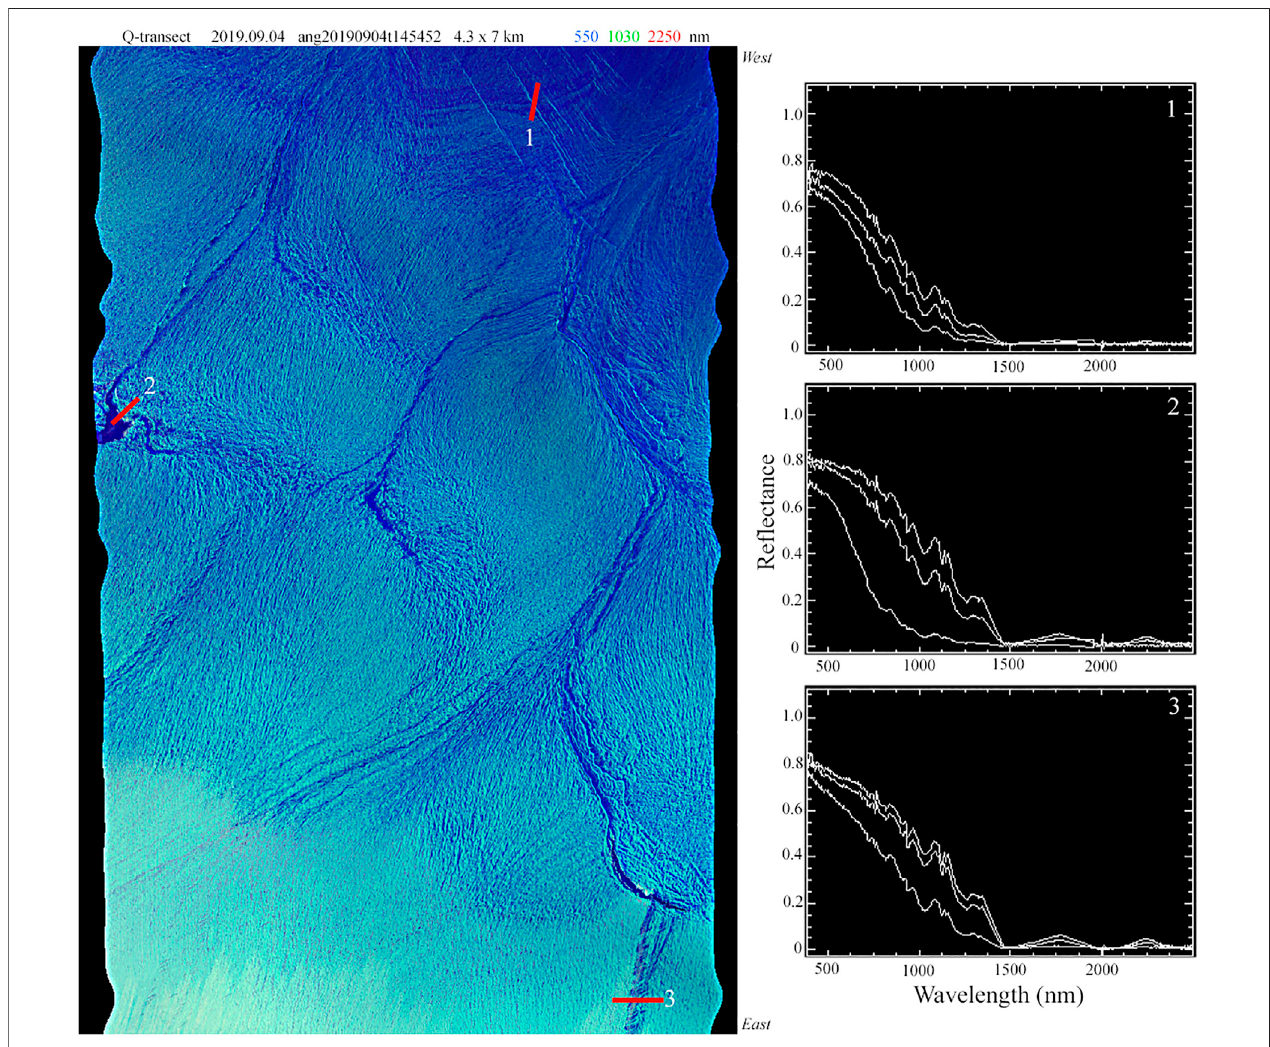
FIGURE 10 | Full resolution AVIRIS-NG swath and spectra from the Q-transect transition zone. Variations in re fl ectance and illumination geometry reveal crevasse texture and surface slope and aspect. Example spectra from adjacent, or near-adjacent, pixels show meter to decameter scale variations in ice and fi rn re fl ectance that would contribute to spectral mixing occurring in decameter resolution imagery. Ground sample distance is 6.4 m.